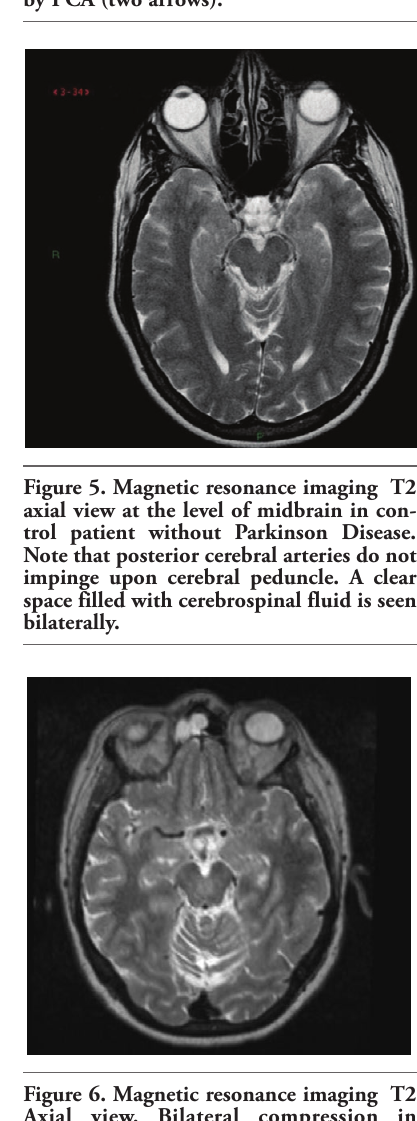
Figure 4. Magnetic resonance imaging T2 axial view two years postoperatively. Recurrence began about 18 months post- operatively. Left caudal peduncle shows implant separating PCA (three arrows). Right cerebral peduncle now compressed by PCA (two arrows).